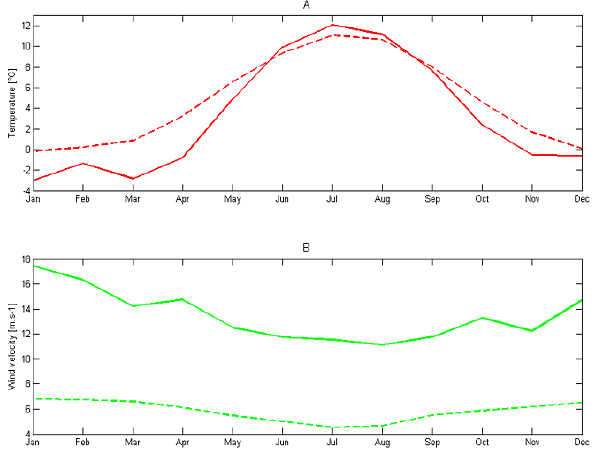
Figure 7. Monthly mean values (solid lines) and total mean values (dashed lines) of temperature (a) and wind velocity (b) during dust events in S Iceland,